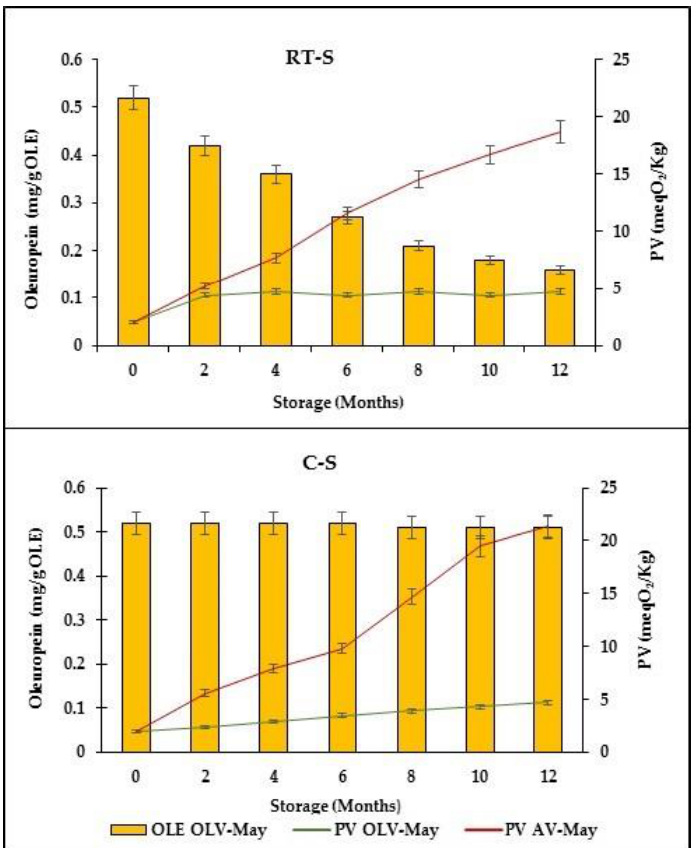
Figure 2. Variation of the oleuropein (OLE) content and peroxide value (PV) measured on the mayonnaise samples prepared with olive leaf vinegar (OLV-May) and alcoholic vinegar (AV-May) and stored at room temperature (RT-S) and cold storage (CT-S) for 12 months. The data are the means ± standard deviation of triplicate measures.